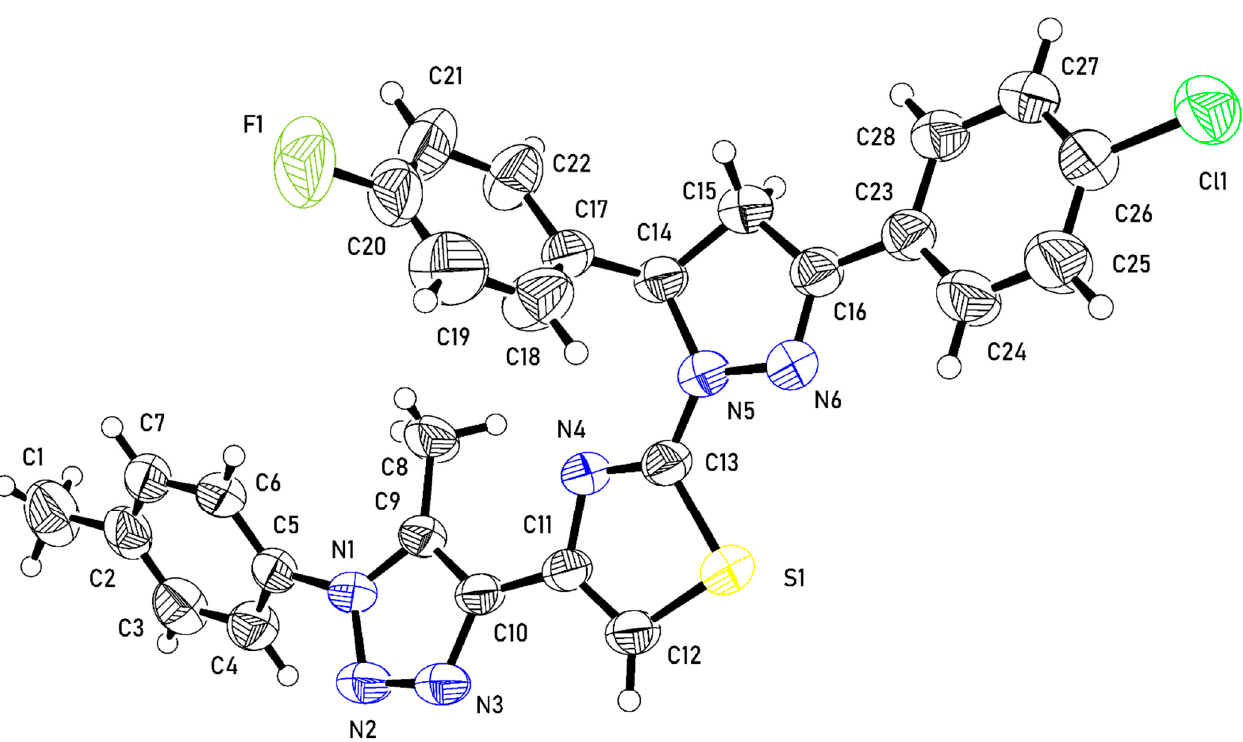
Figure 6. An ortep representation of 14 showing 50% probability atomic displacement ellipsoids.